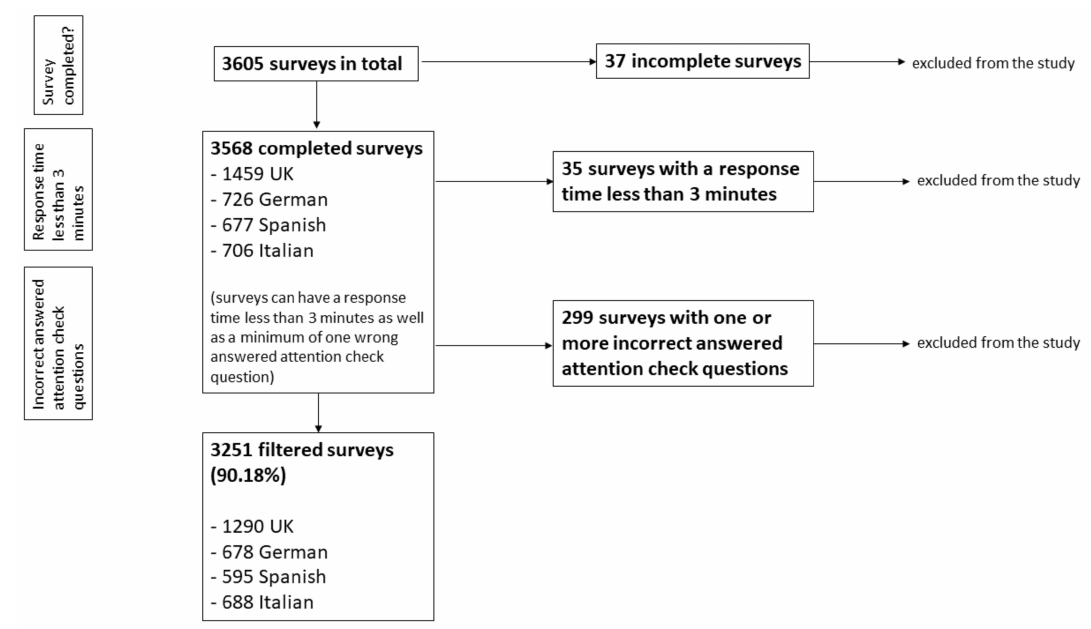
Figure 1. Flowchart of the cleansing process of the survey